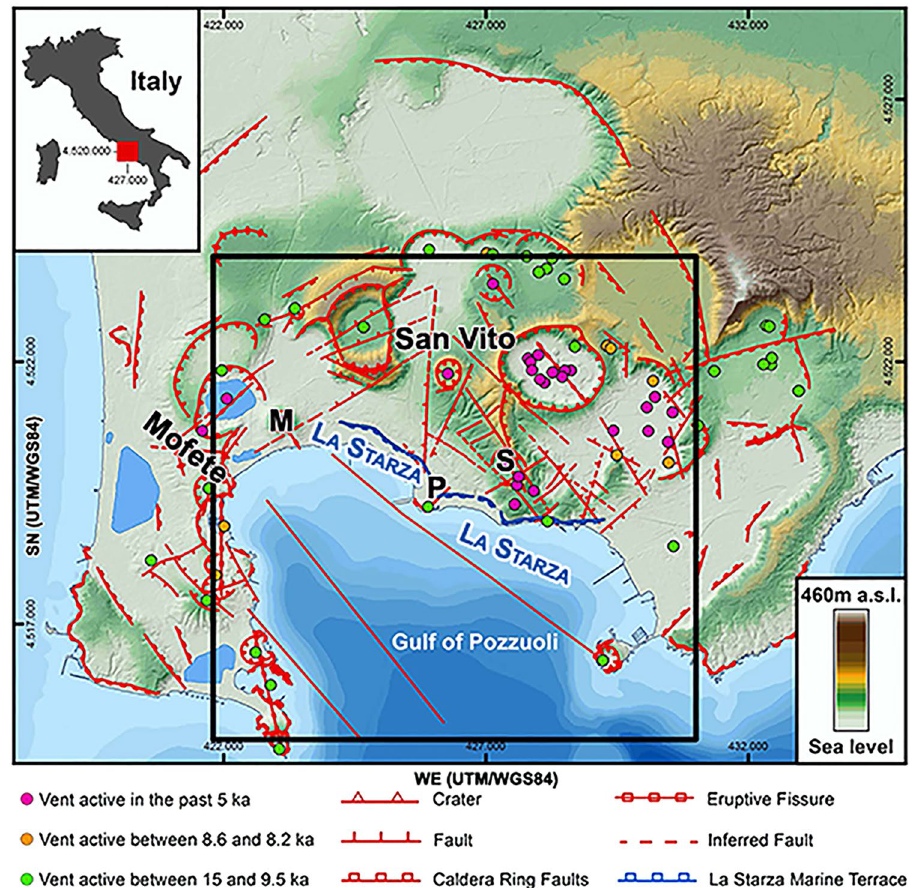
Figure 1. Structural map of Campi Flegrei caldera. The upper left panel shows the caldera location in Italy. Bold letters mark the volcanic centres of Pozzuoli, Solfatara, and Mt. Nuovo. The Naples metropolitan area extends east of Solfatara. Major faults are marked by red lines and volcanic vents coloured by age. Redrawn joining the results in Vilardo et al . 31 and Vitale et al . 30 using ESRI ArcGIS 10.0 (https://www.esri.com/ training/catalog/5763042b851d31e02a43ed4d/using-arcmap-in-arcgis-desktop-10/). Faults and coastline are transformed into a shape file in this workspace and imported in Voxler 3.0 © (http://www.goldensoftware.com/ products/voxler). They are then imposed on all maps reproduced in the following